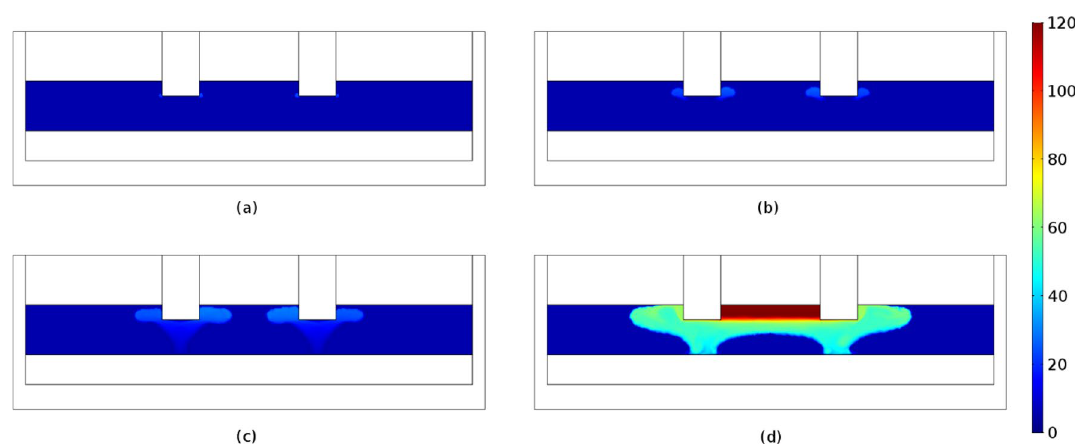
Figure 8. Electrical conductivity (S/m) of the slag phase at times equal to ( a ) 2500 s, ( b ) 5000 s, ( c ) 7500 s and ( d ) 10,000